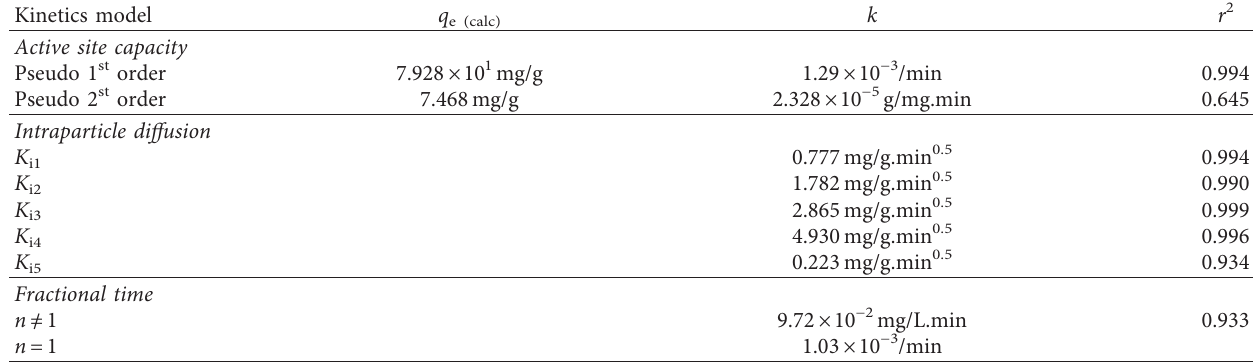
Figure 12: Fractional time models for n � 1 (a) and fractional time models for n ≠ 1 (b) for the adsorption of methyl orange onto cross- linked chitosan beads. Table 2: Summary of the kinetic adsorption